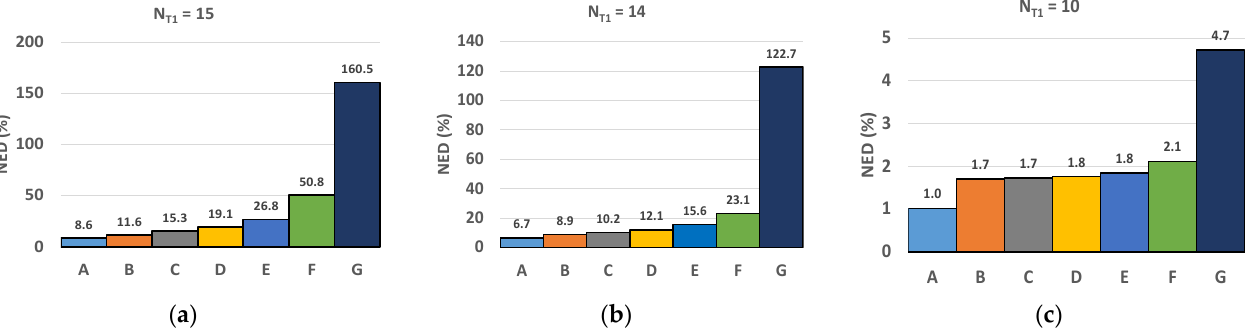
Figure 7. Obtained NED (normalized error distance) for a 7 × 7 convolution applied on the airplane benchmark: ( a ) N T 1 = 15, ( b ) N T 1 = 14, ( c ) N T 1 = 10. F = 4. A: Proposed approach with N T 2 = 0 and double computation on the same pixel to update the CF dyn . B: Proposed approach with N T 2 = 0 and adopting simplifications (1) and (2). C: Same as B, with N T 2 = N T 1 − 2. D: Same as B, with N T 2 = N T 1 − 3. E: Same as B, with N T 2 = N T 1 − 4. F : Same as B, with N T 2 = N T 1 − 5. G: Conventional static correction with N T = N T 1 truncated